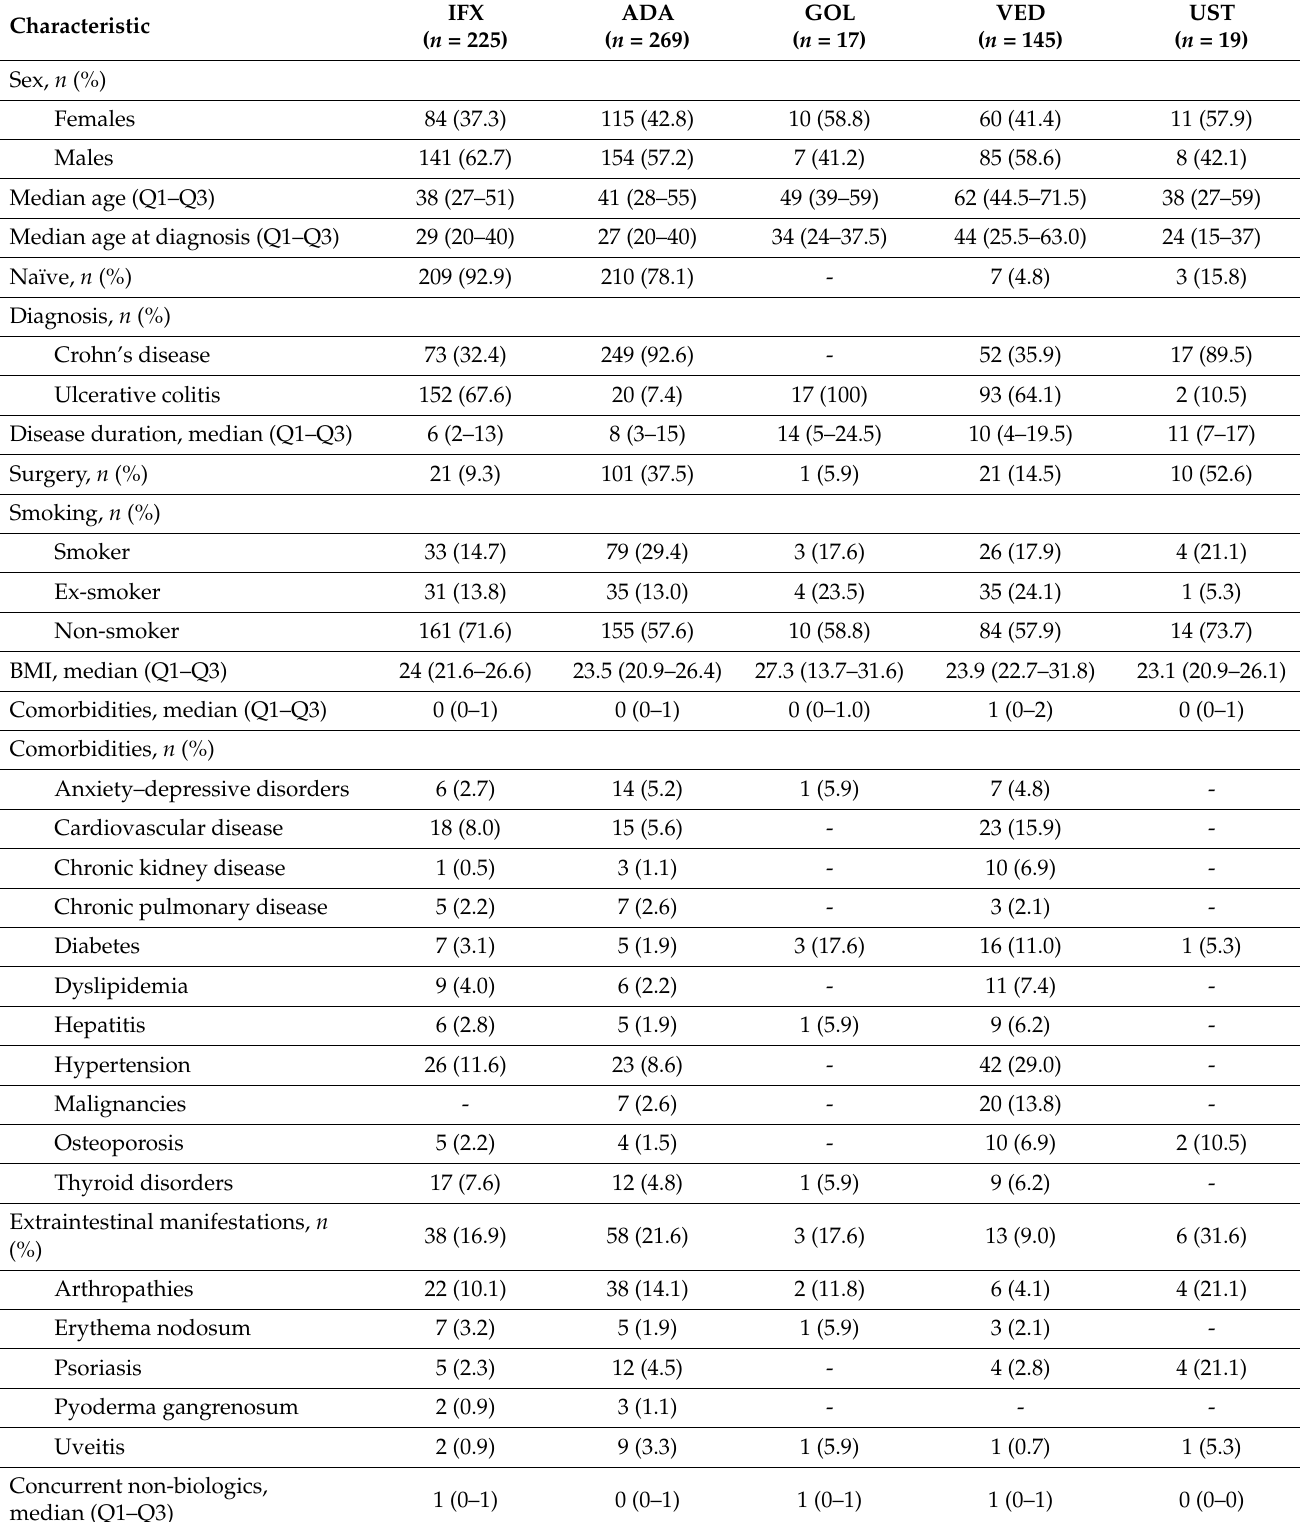
Table 2. Basal characteristics of patients affected by IBD for each